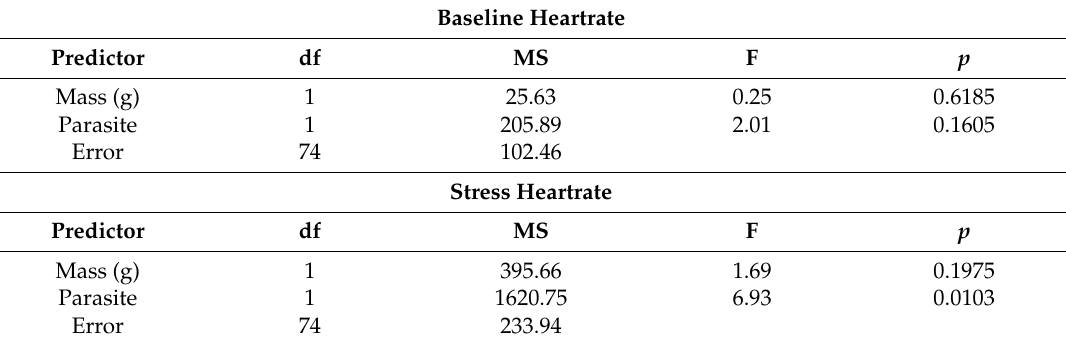
Table 4. Summary of ANOVA models examining effects of nematode parasite on baseline and maximum HR elevation (as a percentage of the initial HR) during stress application in experiment 2 ( n = 77 beetles). Maximum stressed HR (beats/min) was not statistically evaluated for parasite effects (but see Table 3).